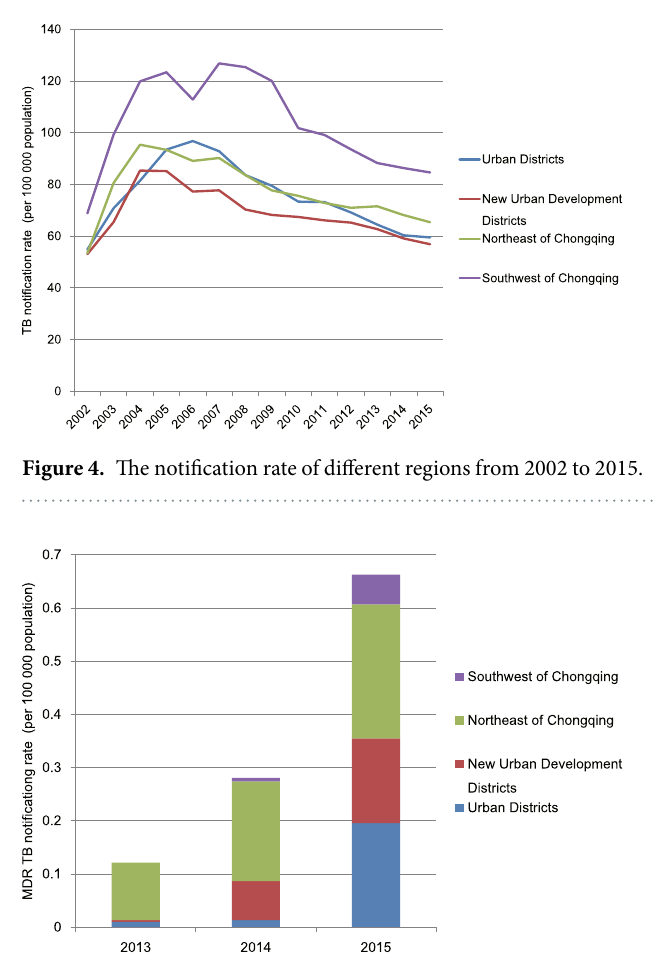
Figure 5. The notification rate of MDR-TB in different regions from 2013 to